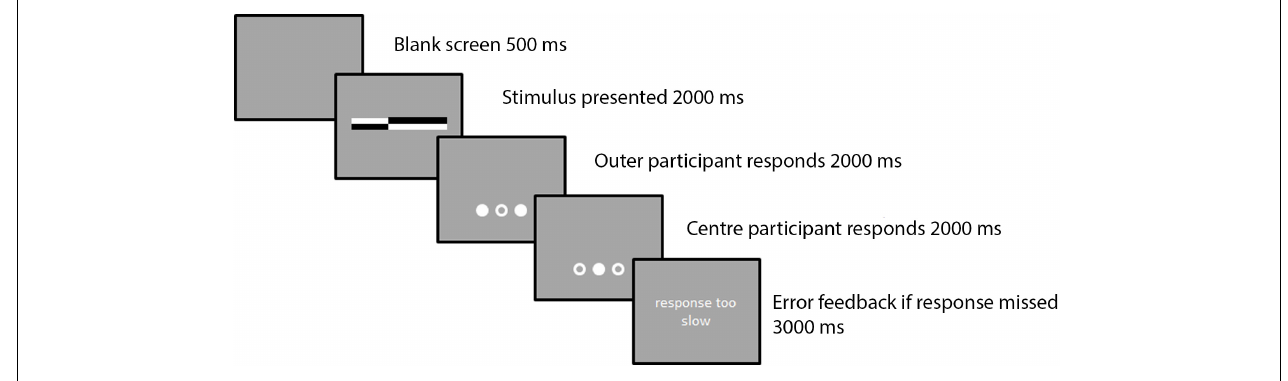
FIGURE 1 | A sample trial